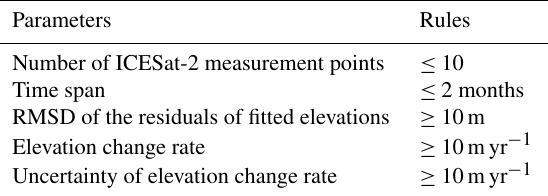
Table 2. Quality control criteria applied to remove the unrealistic elevations due to the poor fitting performances in each grid